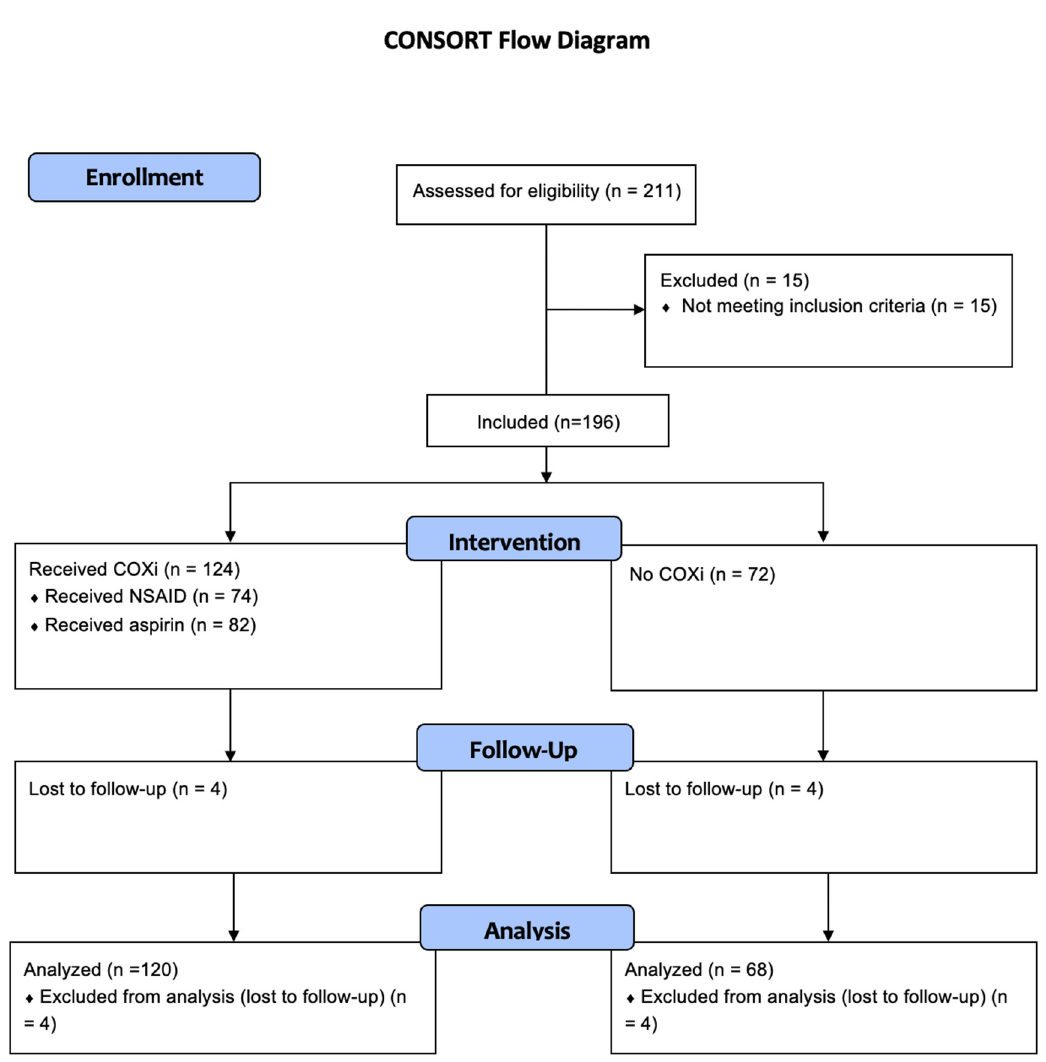
Figure 1. CONSORT flow diagram of patient distribution. Table 1. Characteristics of 188 Patients who Received Immune Checkpoint Inhibitors for Metastatic Renal Cell Carcinoma.